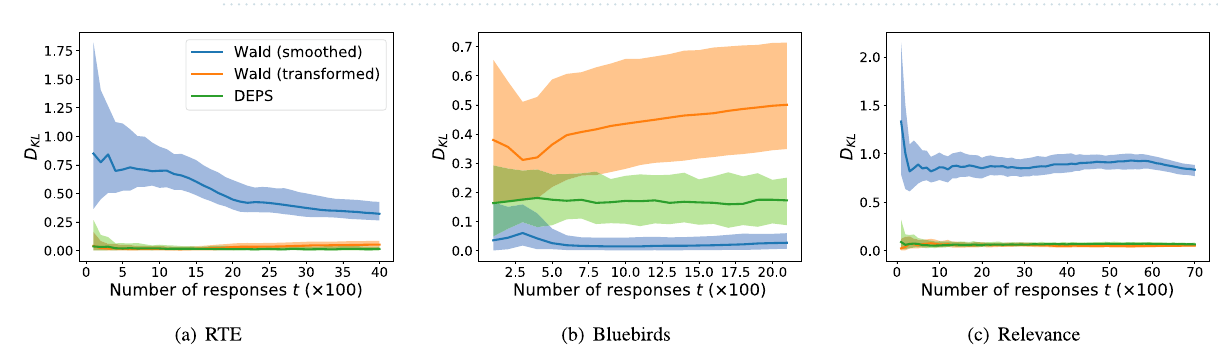
Figure 4. Convergence of estimated distributions as more crowd data are used. Visually, we see that DEPS and Wald (transformed) both converge relatively quickly, often after using only 10% of the available data.